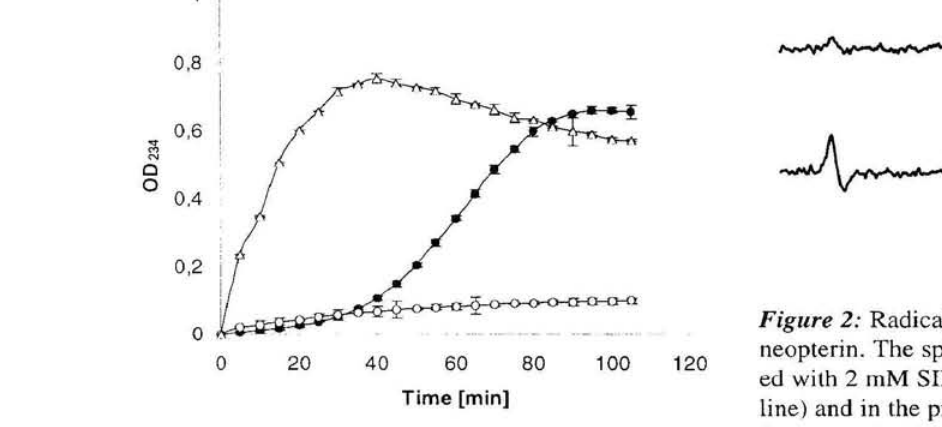
Figure 2: Radical formation from SIN-1 and dihydro- neopterin. The spin trap TMIO (10 mM) was incubat- ed with 2 mM SIN-1 for 10 min in the absence (upper line) and in the presence (lower line) of 500 μΜ dihy- droneopterin. Radical formation was followed by EPR